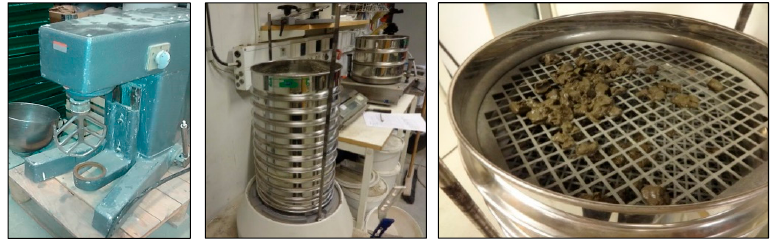
Figure 2. Laboratory mixer and sieving test for wet soil specimen. Table 4. The test program for homogenizing and disintegrating the natural soil.